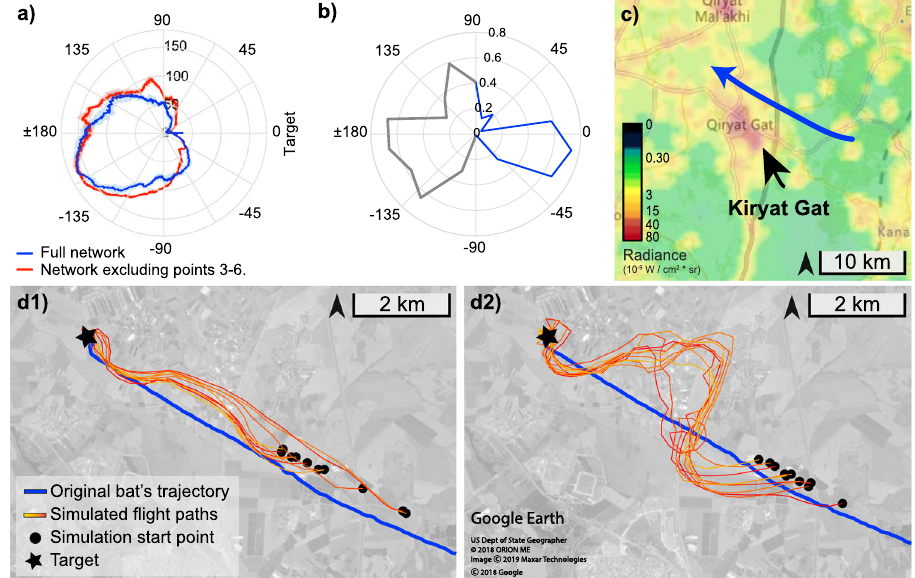
Fig. 2 Navigation performance. a The performance of the network as a function of the angle relative to the target is plotted as a polar plot. Data were collected from seven points along the bat ’ s trajectory. Error represents the mean error over all test images taken randomly along the route. 2521 images for the blue line depicting the error of the network trained on all data; and 2517 images for the red line depicting the error of the network trained on all data excluding points 3 – 6. Positive angles represent angles between 0 and 180° and negative angles are between 180 and 360°. b Percentage of light at a certain angle, relative to the entire measured area, in a distance of up to 15 km from the cave (illumination levels were measured in units of radiance 10 − 9 W/cm 2 × sr. 0 degrees represent the direction of the target relative to the cave). Note that bats probably rely on visual information in the direction of their fl ight (blue line) and thus do not rely on visual information that is greater than ±90° of their fl ight direction (gray line). c The bat ’ s trajectory (blue line) is overlaid on the background of an arti fi cial lightmap. The lightmap was obtained from Jurij Stare, using NASA ’ s Black Marble nighttime lights product. d Trajectories of the bat-simulator show network-based navigation for the network that was trained on all data ( d1 ) and on part of the data ( d2 ). Ten examples are shown for each network. Note how the network trained with partial data ( d2 ) has a much larger error between points 3 and 6, a route that the network has not ‘ seen ’ before, but it eventually manages to reach the target (black star). The satellite images were obtained from Google Earth,